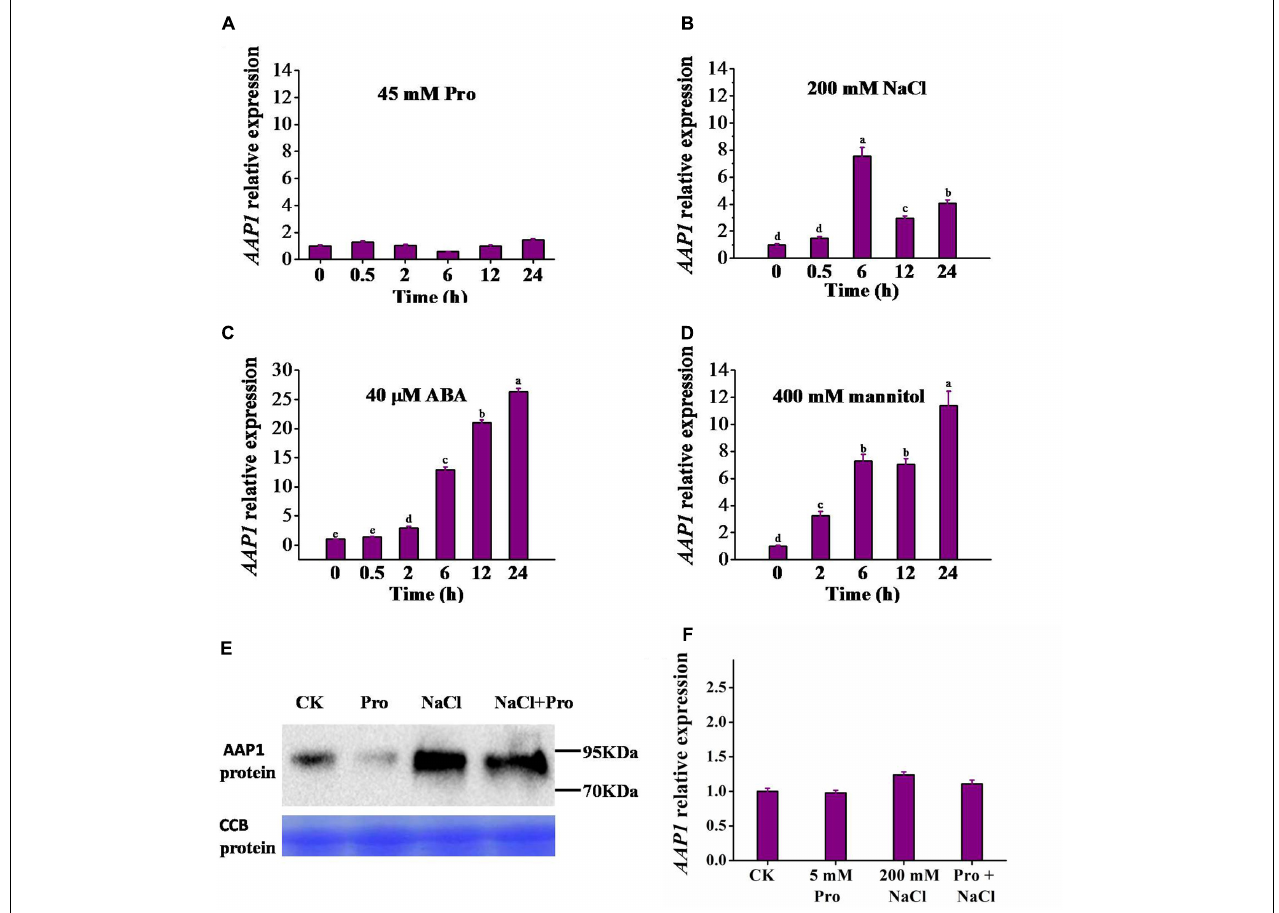
FIGURE 4 | Induction of AAP1 transcript and AAP1 protein level by different treatments. AAP1 relative expression level analyzed using real-time RT-PCR in 12-day-old wild-type (Col) seedlings following treatment for different time periods with 0.5 × MS liquid medium containing (A) 45 mM L -proline (Pro), (B) 200 mM NaCl, (C) 40 µ M abscisic acid (ABA), or (D) 400 mM mannitol. (E) AAP1-GFP protein level in 35S-PRE1:GFP seedlings following a 10-h treatment with various compounds. (F) AAP1 relative expression level in 35S-PRE1:GFP seedlings following a 7 h treatment with 5 mM Pro, 200 mM NaCl, or 5 mM Pro and 200 mM NaCl. 35S-PRE1:GFP , pre1-1 transformed PRE1 cDNA fused with GFP driven by the 35S promoter. Experiments were repeated a minimum of three times with similar results and data are means ± standard error ( n = 3). Different letters above columns indicate significant difference ( P < 0.05, Duncan’s multiple range